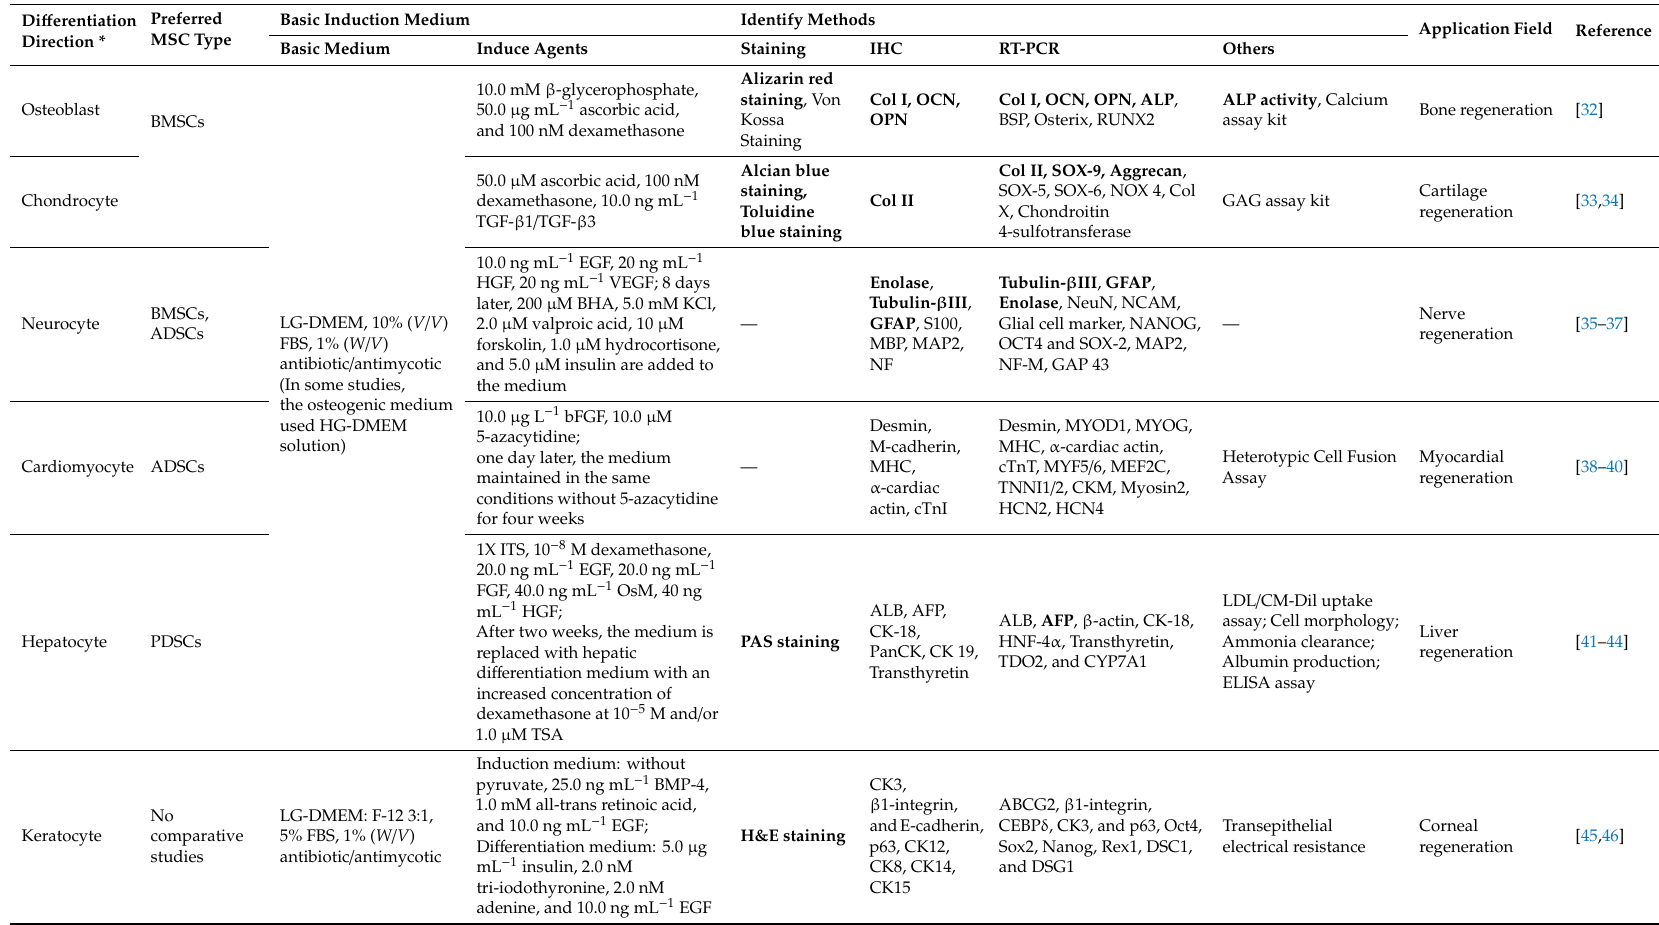
Table 2. Summary of di ff erentiation researches and application potential of